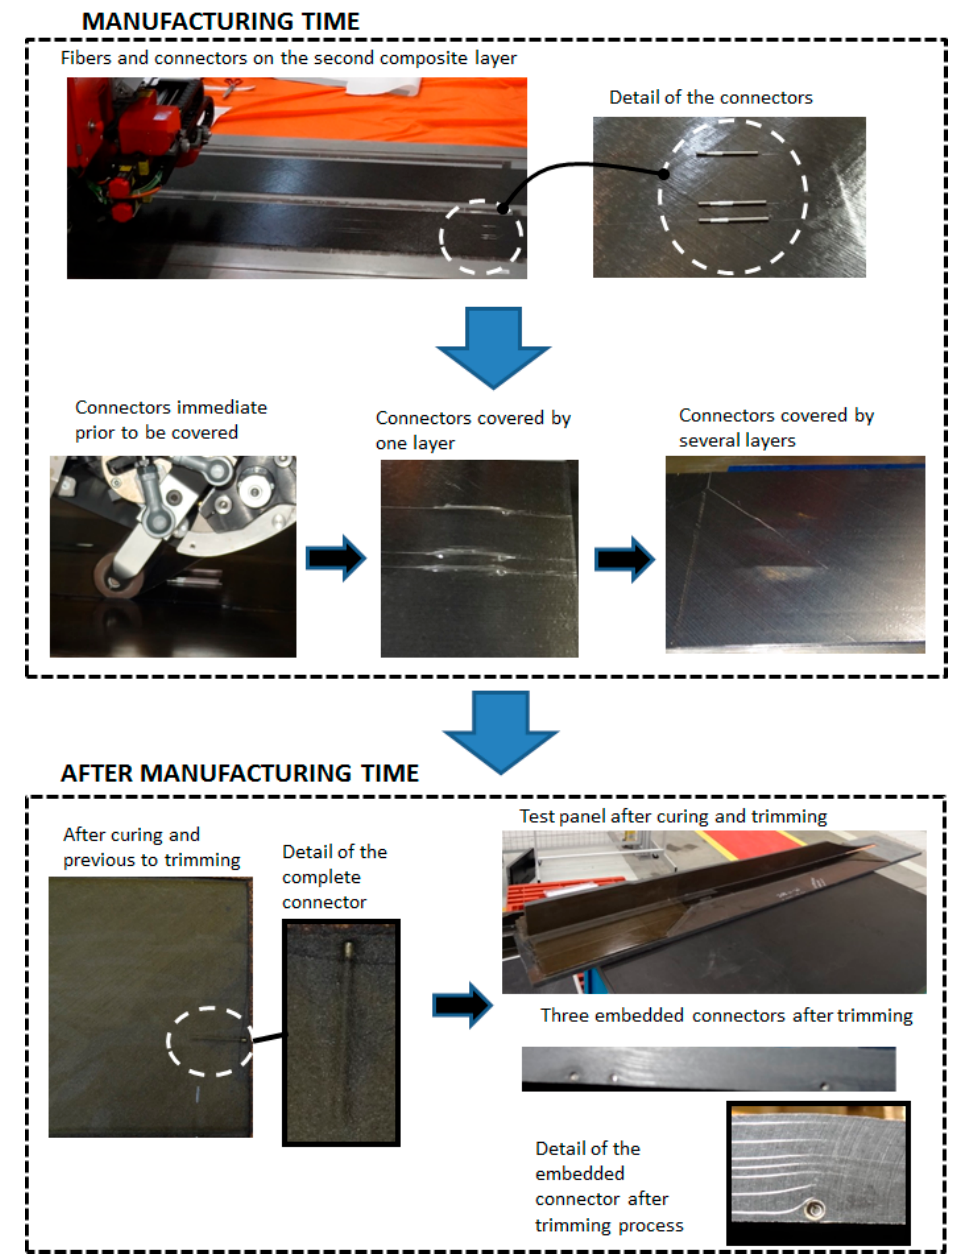
Figure 5. Optical fiber connector at different times during the manufacturing process.